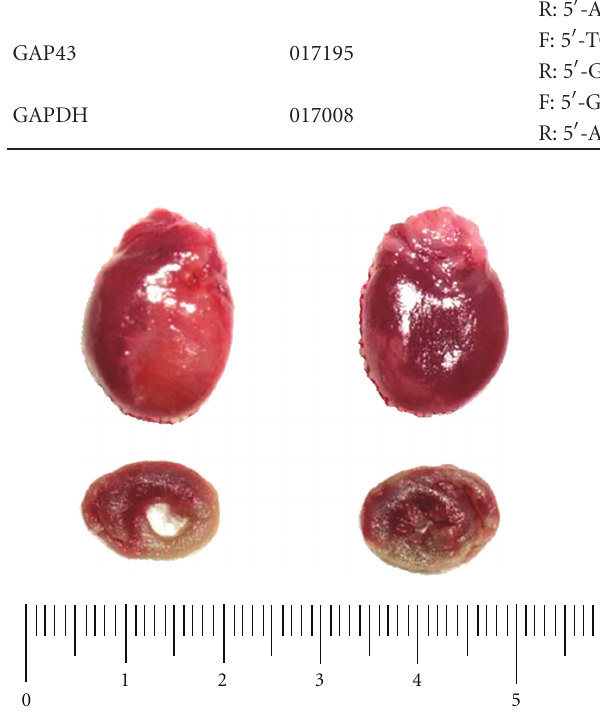
Figure 1: TTC staining of a rat heart one week after myocardial ischemia-reperfusion. The heart in the infarct area was pale.